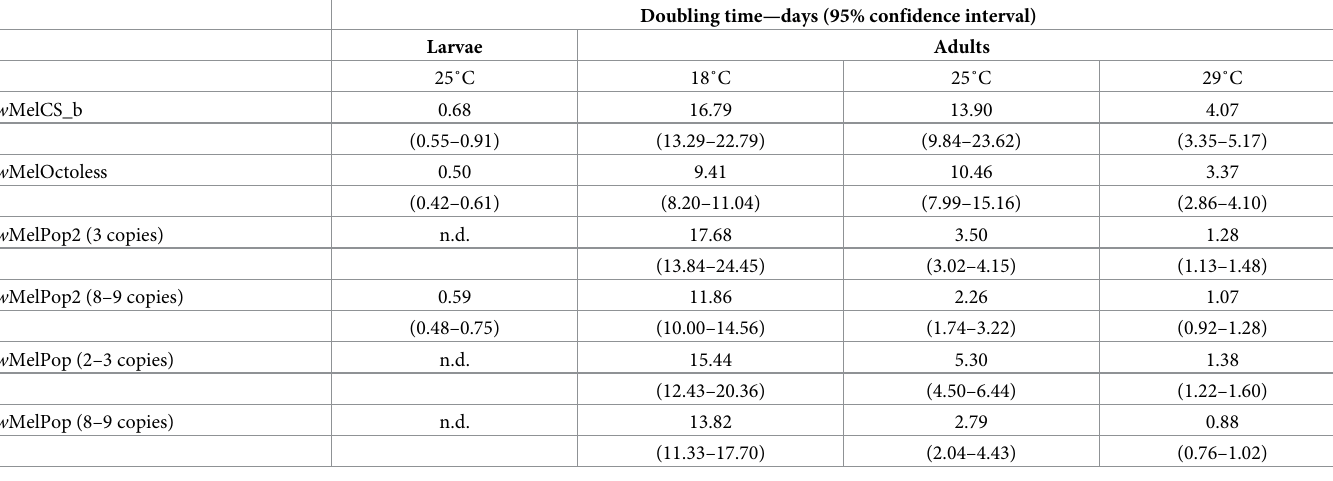
Table 1. Doubling time of Wolbachia variants in larvae and adults at different